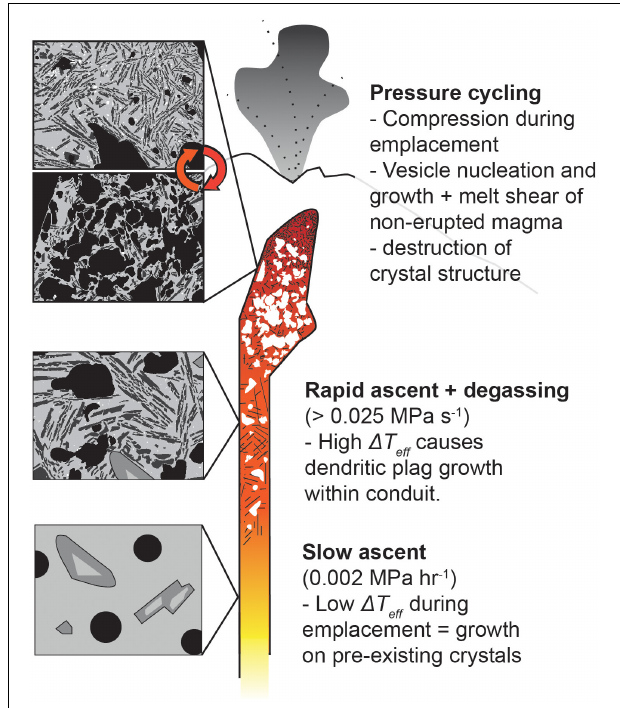
FIGURE 6 | Schematic of Mount St Helens magma ascent path. Slow ascent (0.002 MPa h − 1 ) from the deep storage region suppresses plagioclase nucleation and favors growth on pre-existing crystals. At pressures ≤ 50 MPa, high effective undercooling ( (cid:49) T eff ) and sluggish kinetics at high melt viscosity cause dendritic microlites to form. The magma underwent compression during intrusion into the edifice then experienced a series of recompression—decompression events during phreatomagmatic explosions. Pressure cycling damaged the dendritic crystal structures, which created numerous, small crystal